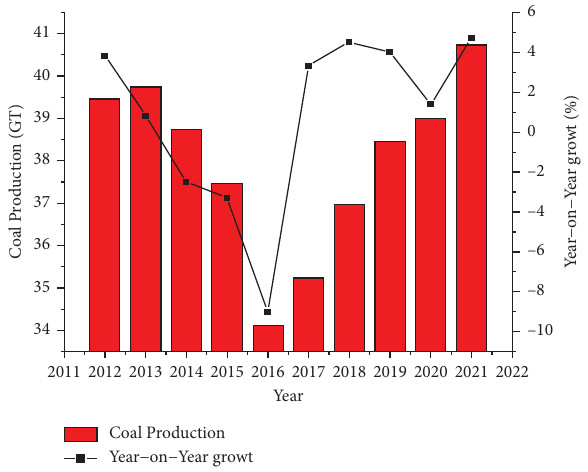
Figure 1: Coal output of China for nearly ten years.